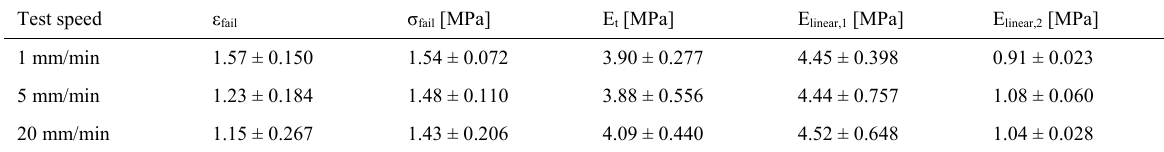
Table 2: Characteristics of Sikasil ® SG-500 in tension ( ε fail = average strain at failure, σ fail = average stress at failure, E t = Young’s modulus, E linear,1 = modulus for the linear approximation of the first linear region of the graph, E linear,2 = modulus for the linear approximation of the second linear region of the graph). Test